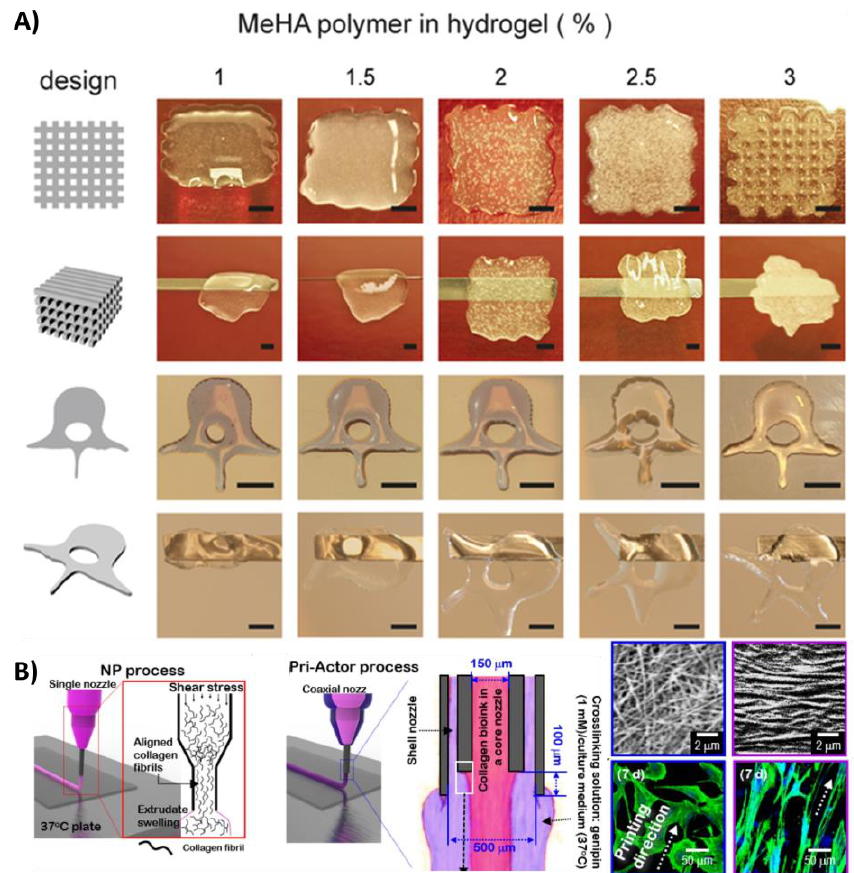
Figure 4. Examples of naturally derived bioink applications. Using hyaluronic acid and extrusion- based printing technologies, designs of both porous cubes and non-porous L3 vertebras can be achieved with good shape fidelity and tissue regeneration properties ( A ). Reprinted with permission from ref. [115] . Printing collagen fibres with a Pri-Actor system enables the hydrostatic forces to align the fibrils and subsequently the orientation of F-actin of encapsulated hASCs ( B ). Reprinted with permission from ref. [140] .